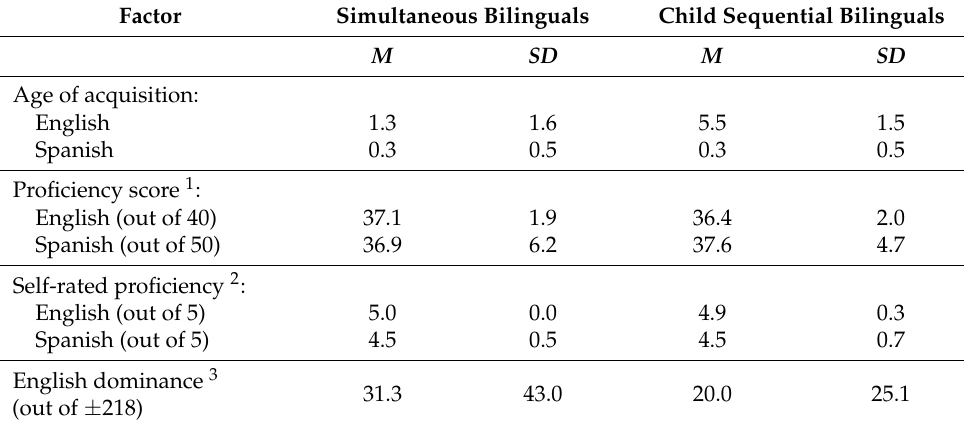
Table 1. Participant